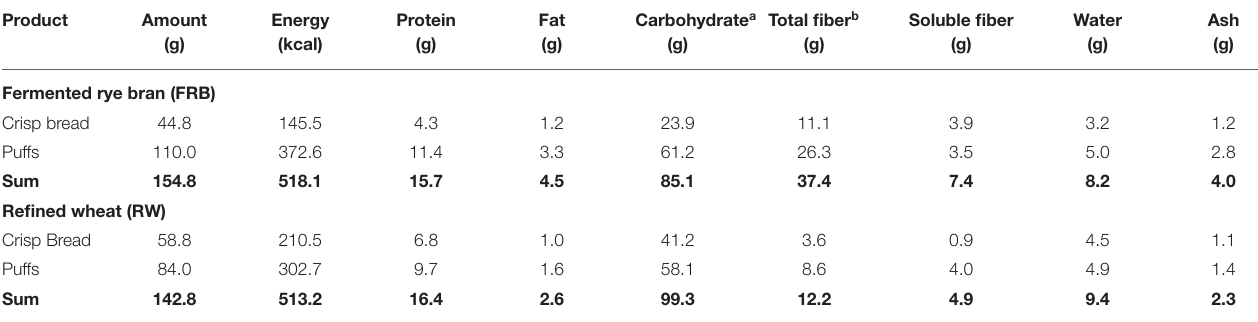
TABLE 1 | Daily nutritional composition of fermented rye bran and refined wheat